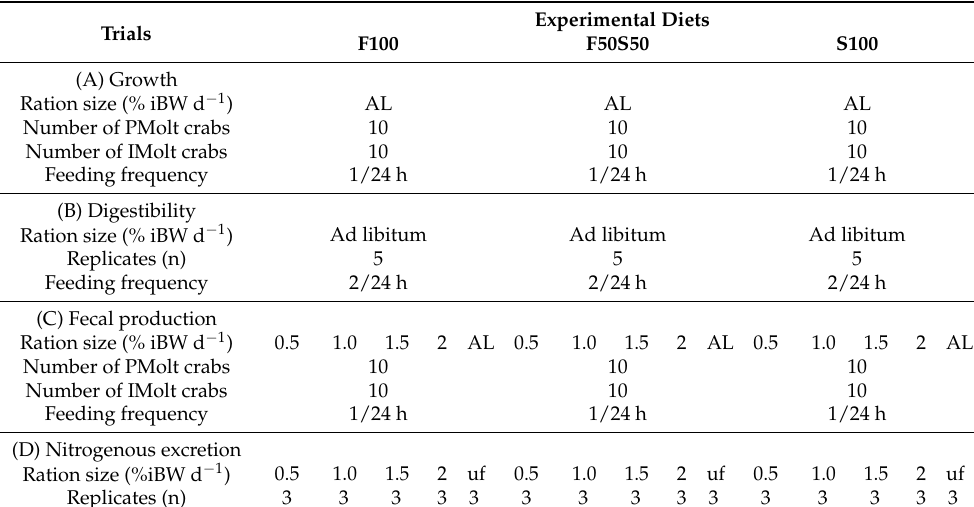
Table 2. Experimental design of trials: growth (A), digestibility (B), fecal production (C) and nitroge- nous excretion